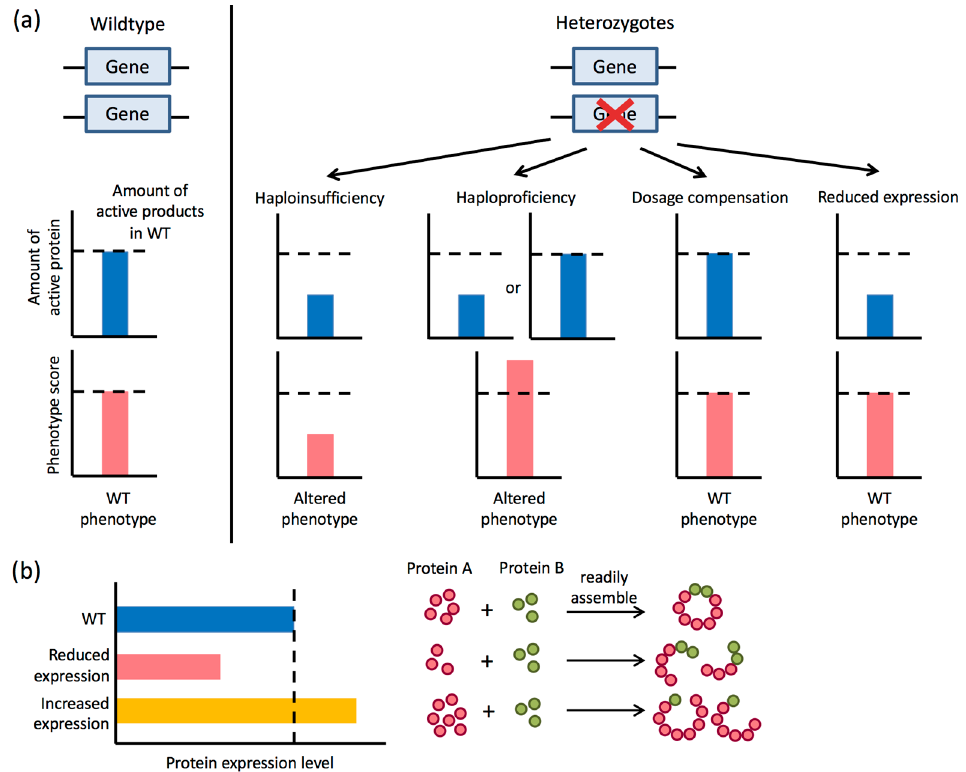
Figure 2. Potential phenotypic outcomes in diploid heterozygotes. ( a ) Loss of one allele of a gene will result in alternative outcomes including haploinsufficiency, haploproficiency and dosage compensation. Haploinsufficiency causes fitness defects, which often constitute a recessive phenotype associated with reduced gene expression. Haploproficiency occurs when one functional allele generates the opposite phenotype of the null mutant, and can be due to either increased or decreased protein levels. Heterozygous cells can also show a normal phenotype, either because reduced gene expression does not produce a phenotype or due to dosage compensation. ( b ) Changes in gene expression are particularly likely to impact phenotypes when the gene product is part of a larger protein complex, as this can cause an imbalance in subunit stoichiometry. WT, wildtype.